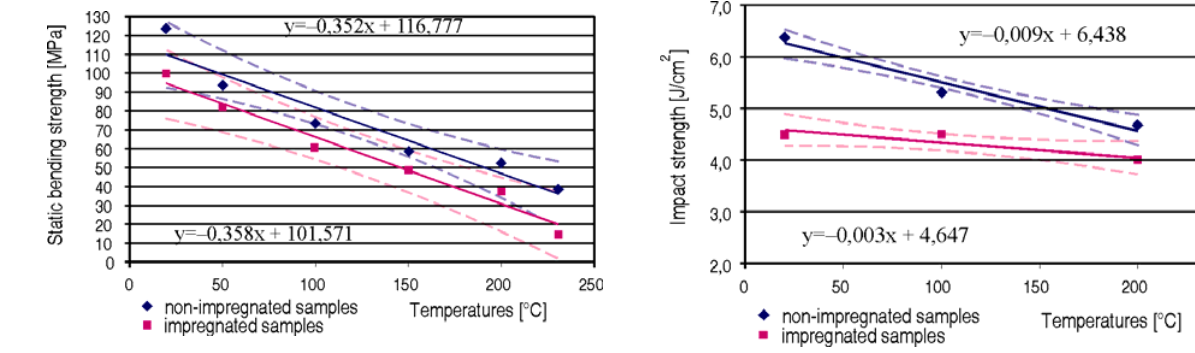
Fig 7. Static bending strength vs temperature for impreg- nated and non-impregnated wood